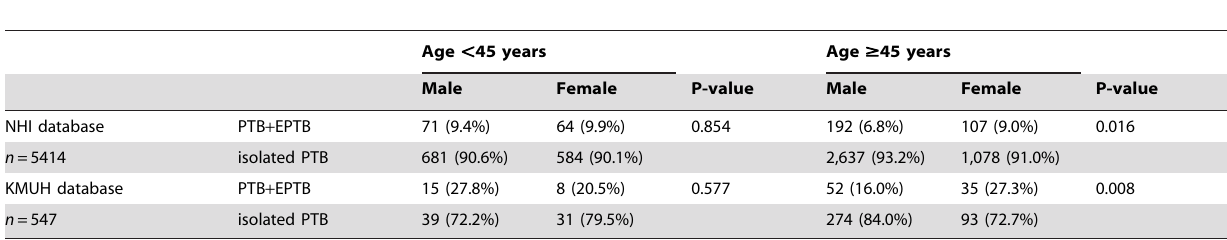
Table 2. The occurrence of concurrent EPTB in patients with PTB by age and gender groups, from NHI and KMUH